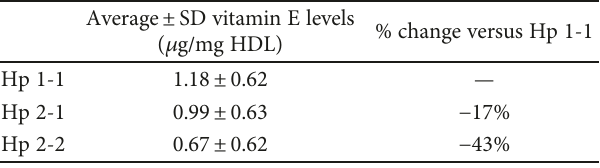
Figure 6: (a-b) Detection of cross-links on HDL with anti-ApoA1 and Hp antibodies. The same membrane from Figure 5 was reblotted and was incubated with anti-Apo A1 (panel a) or anti-Hp (panel b). Table 1: Measurement of vitamin E levels in HDL from diabetic individuals